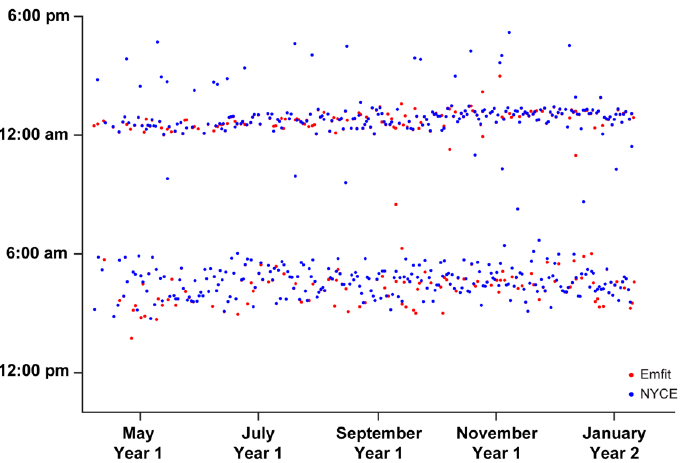
likely explanation for these data reflects participants falling asleep in a chair or couch (e.g., while watching television) prior to getting into bed.